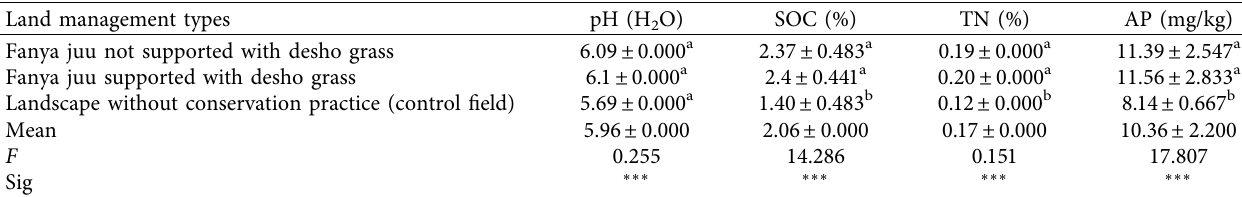
Table 2: Efects of land management on selected soil properties (mean ± standard deviations).